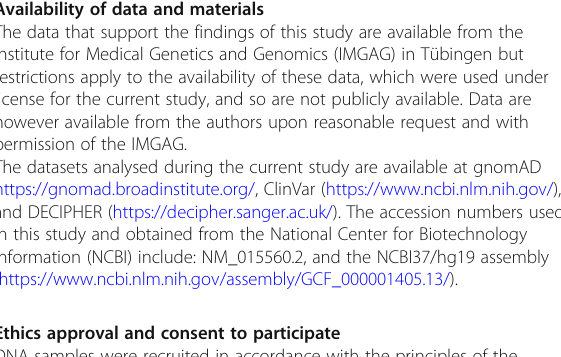
Additional file 1: Figure 1. Results of perimetry. Additional file 2: Figure 2. Results of panel D15